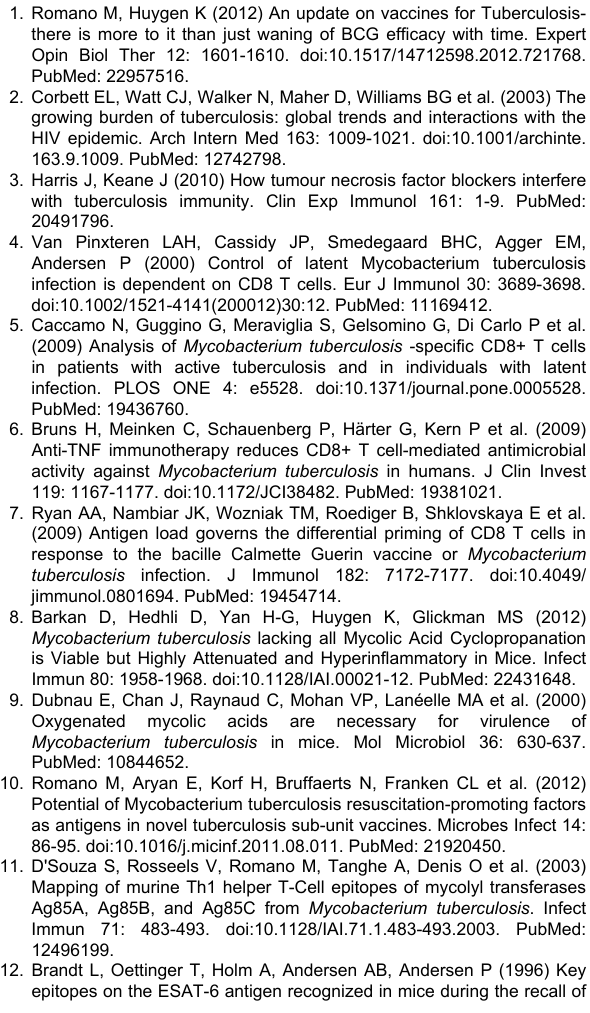
Figure S1. MGM1991 mutant shows attenuated phenotype as compared to wild type M.tb Erdman strain in intratracheally infected C57BL/6 and DBA/2 mice. (A) C75BL/6 mice were infected by intratracheal (IT) route with 10 4 CFU/mice of WT M.tb strain (Erdman) or MGM1991 M.tb strain and bacterial burden in lungs was evaluated at days 7, 21 and